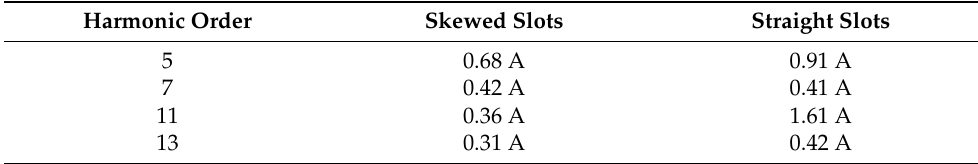
Table 3. Current harmonic amplitude at 3000 rpm and rated